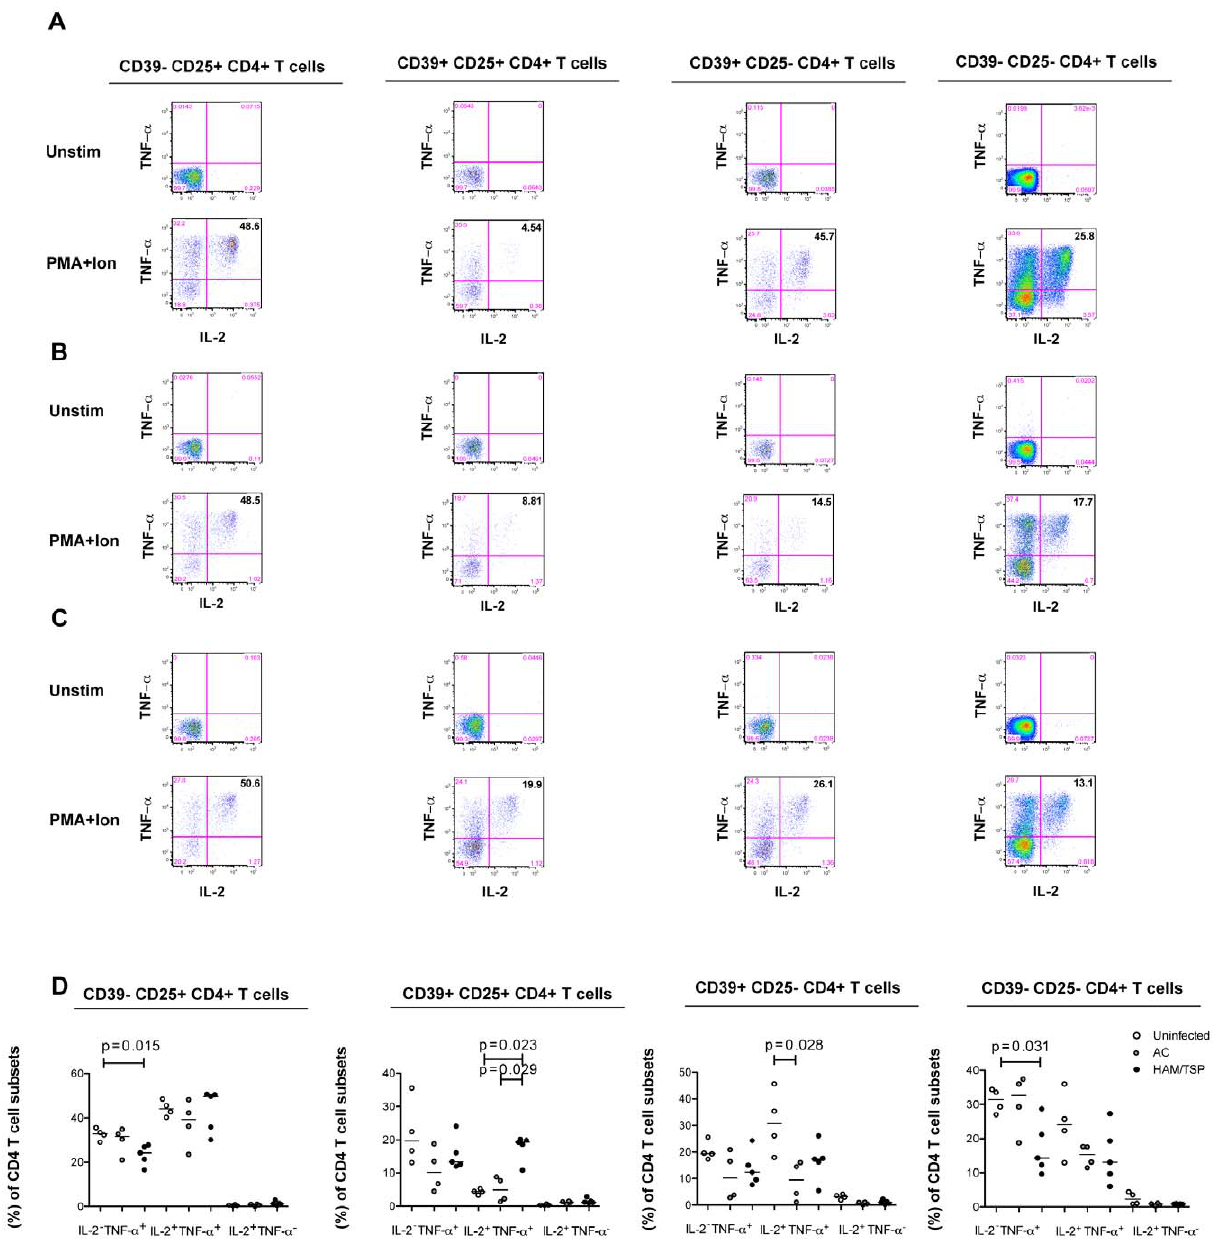
Figure 6. TNF- a and IL-2 production by CD4 + T cells based on CD39 and CD25 expression. The statistical difference was deemed significant using a Mann-Whitney U test analysis if p , 0.05. Horizontal bars denote median values. TNF- a and IL-2 production by CD4 + T cells from (A) one representative uninfected donor, (B) one HTLV-1 asymptomatic carrier and (C) one HAM/TSP. (D) Production of TNF- a and IL-2 by CD4 + T cells in AC and HAM/TSP patients and uninfected donors based on CD39 and CD25